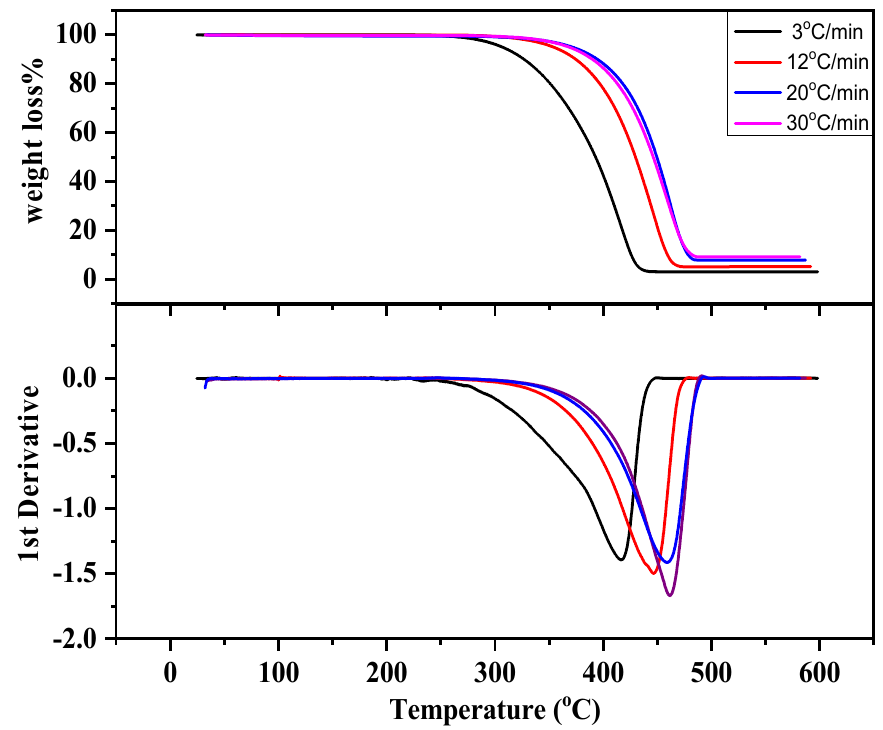
Figure 1. TG/DTG curves of PP waste obtained at various temperature program Figure 1 TG/DTG curves of PP waste obtained at various temperature program rates.